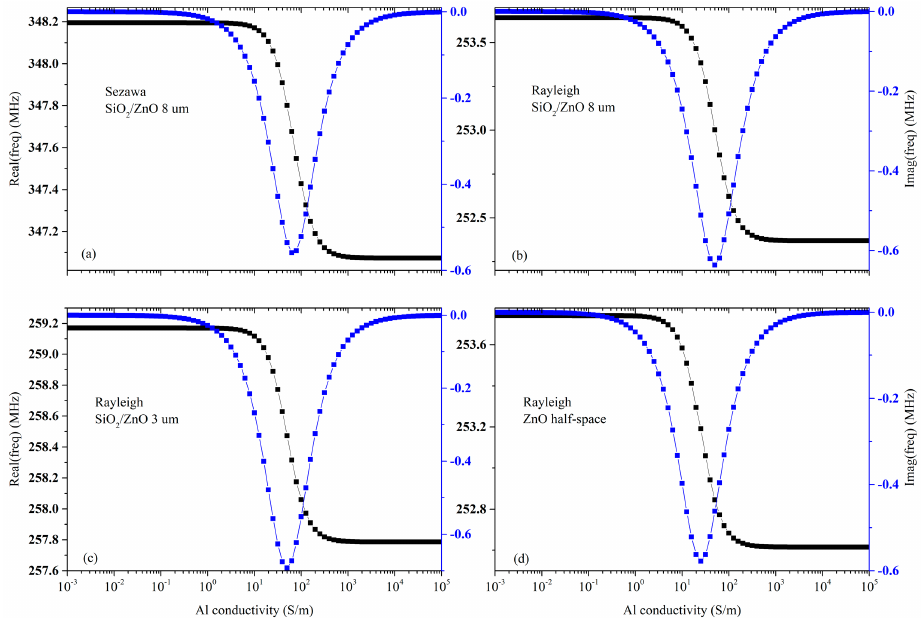
Figure 4. The real and imaginary part of the resonant frequency vs. Al conductivity of the ( a ) Sezawa wave travelling along Al/ZnO (8 µ m)/SiO 2 substrate; ( b ) Rayleigh wave travelling along the Al/ZnO (8 µ m)/SiO 2 substrate; ( c ) Rayleigh wave travelling along Al/ZnO (3 µ m)/SiO 2 substrate; ( d ) Rayleigh wave travelling along a ZnO half-space covered by the thin Al layer. The acoustic wavelength is λ = 10 um and the Al layer is 0.05 um thick.